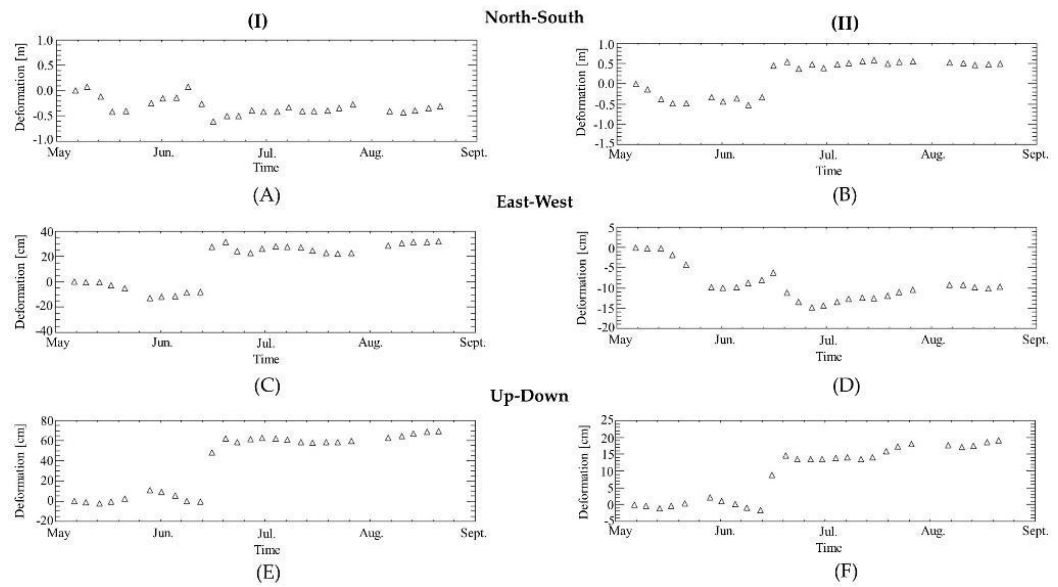
Figure 27. North–south, east–west and up–down displacement time-series related to cross-fault points (I) and (II) indicated in Figures 25 and 26.